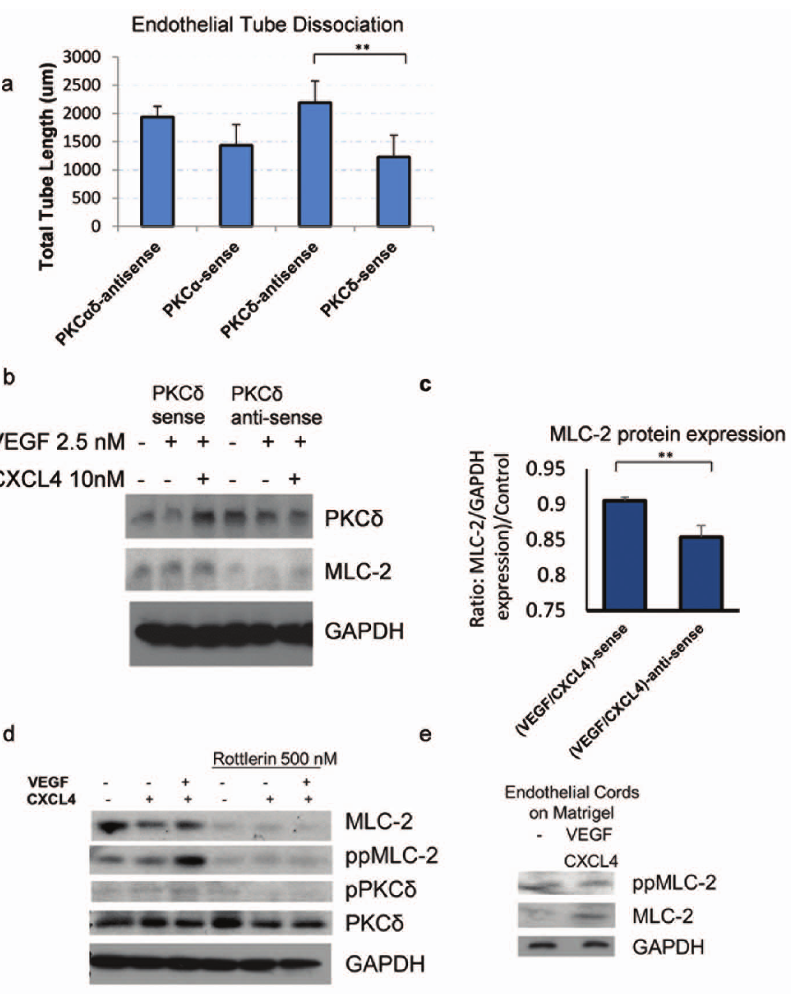
Figure 2. PKC d inhibition decreases CXCL4-induced cord dissociation. a) Cords that were induced to dissociate were quantified using Metamorph as in (Fig. 1b). HMEC cells were allowed to form cords. Following 24 hours, 20 uM of antisense/sense oligonucleotides were added